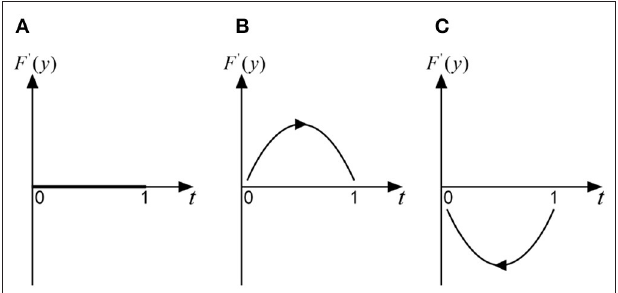
FIGURE 3 | (A–C) The replication dynamic phase diagram of folks in the official-folk game.